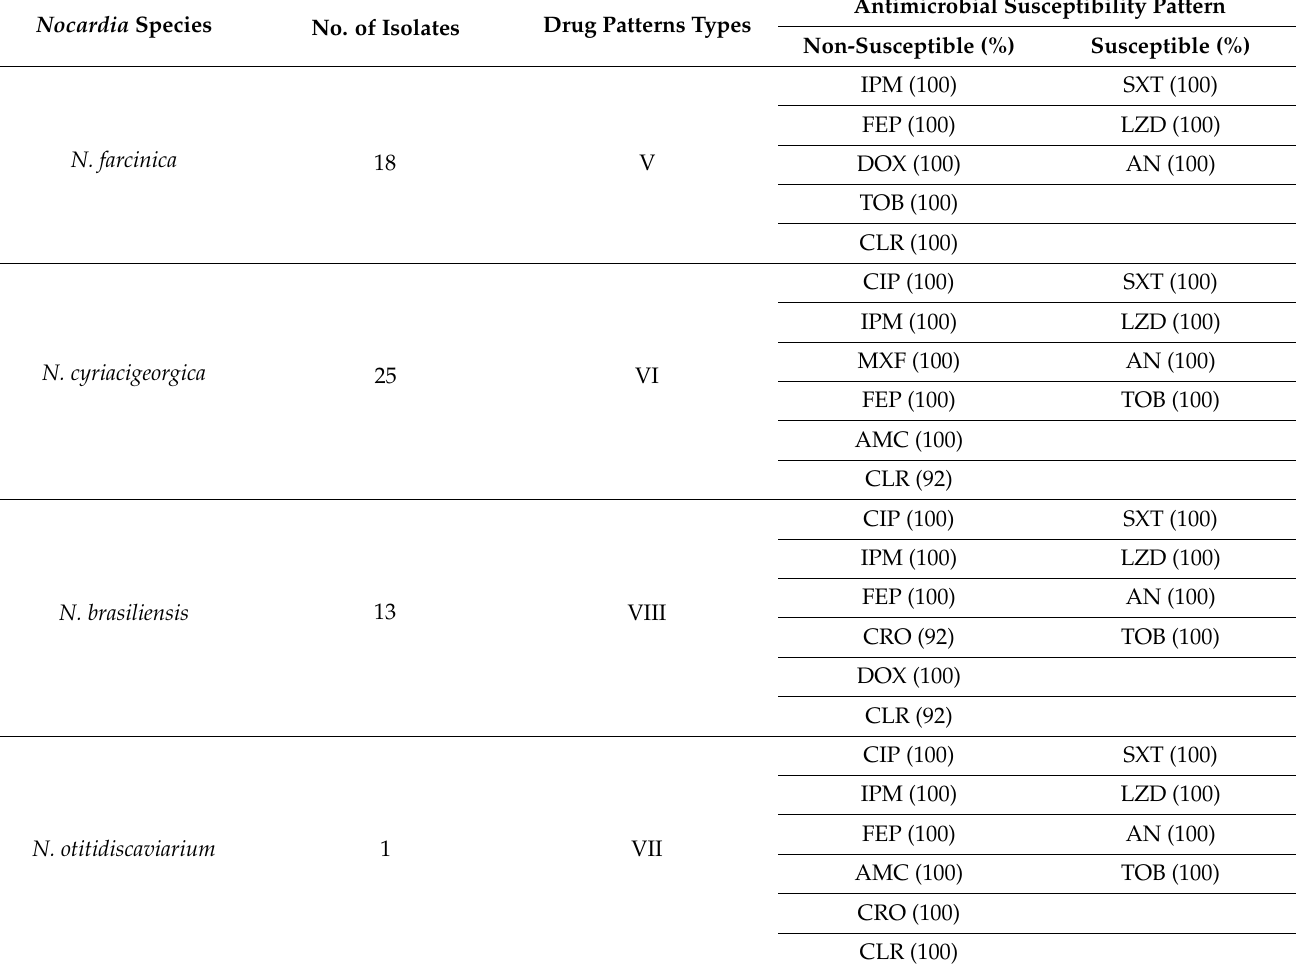
Table 2. The antimicrobial susceptibility patterns of different Nocardia species. Nocardia Species No. of